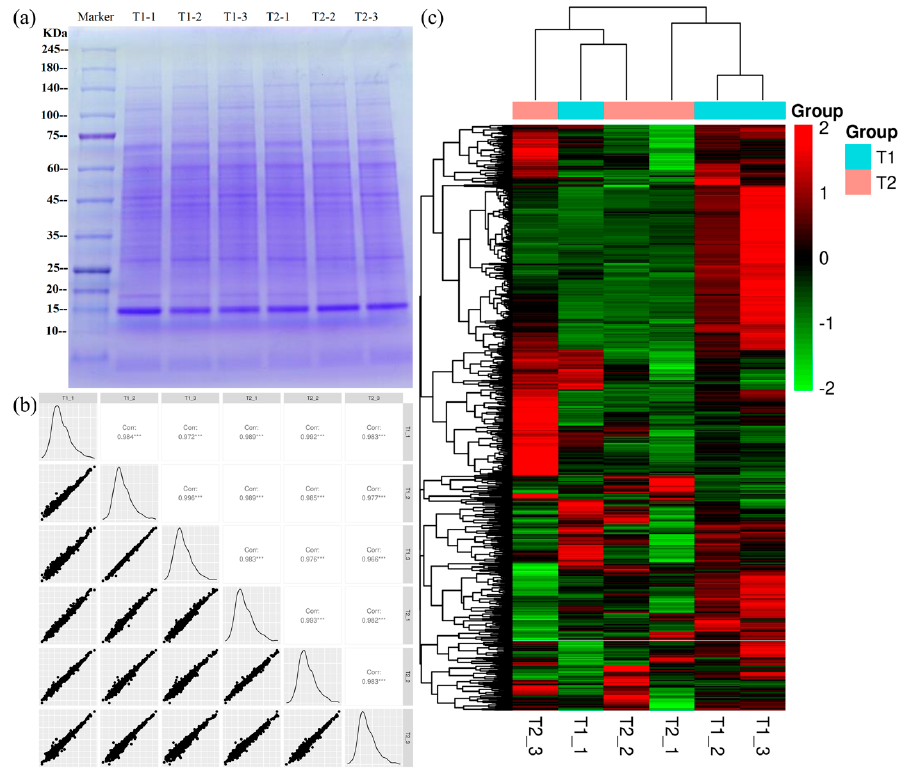
Figure 3. ( a ) SDS-PAGE gel electrophoresis protein profile of chicken liver. ( b ) Protein sample correlation plot (scatter plot). ( c ) Hierarchical clustering of differentially expressed proteins. The protein bands are distributed in a range of molecular weights of 10 to 245 kDa. “corr” is Pearson correlation analysis; “***” is a Pearson correlation greater than 0.8, which is a very strong correlation. The color scale bar located in the right, and green and red indicate decreased and increased levels of the identified proteins,